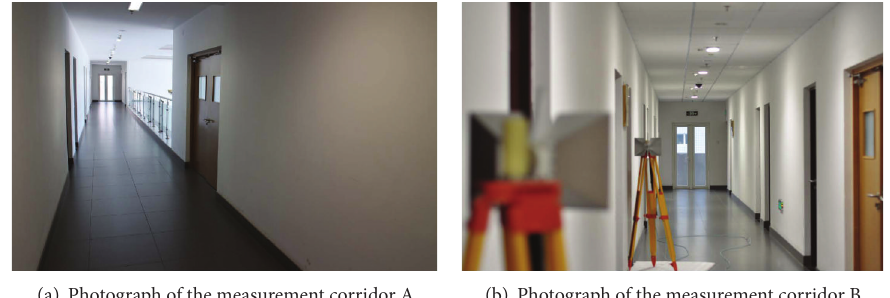
Figure 1: Measurement environments, (a) corridor A, (b) corridor